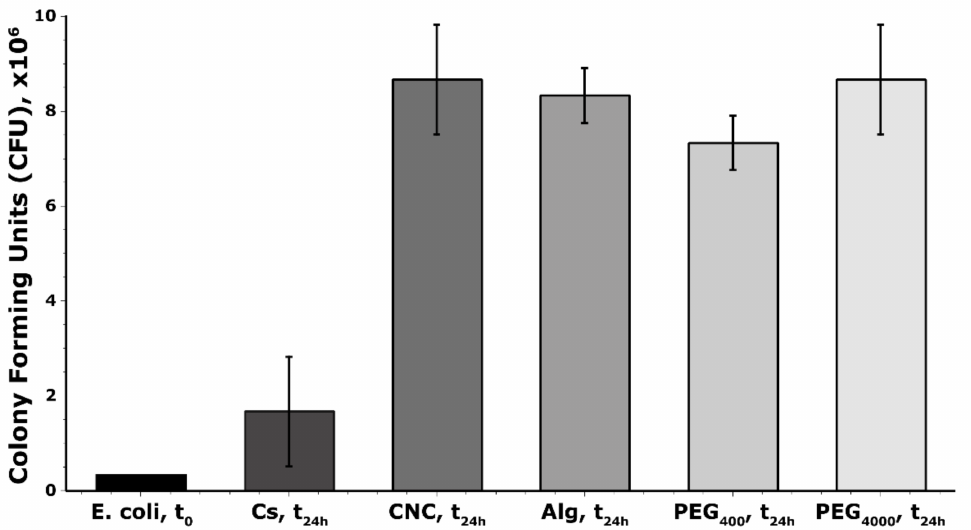
Figure 6. Bar chart showing the number of E. coli after 24 h incubation with chitosan, CNCs, alginate, PEG400 and